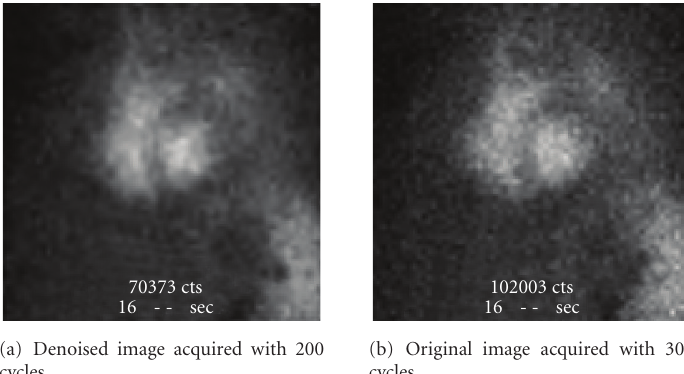
Figure 8: Example of a slide of forced tests.